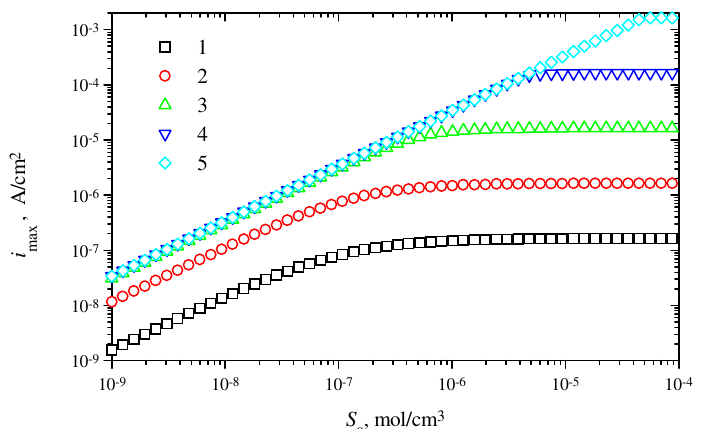
Figure 7 . The dependence of the maximal biosensor current i max on the substrate concentration S 0 at five maximal enzymatic rates V : 10 -10 (1), 10 -9 (2), 10 -8 (3), 10 -7 (4) and 10 -6 (5) mol/cm 3 s, d max = d (10 -8 , 10 -6 , 2 · 10 -8 ) = 0.017 cm, calculated by formula (18) accepting d = d